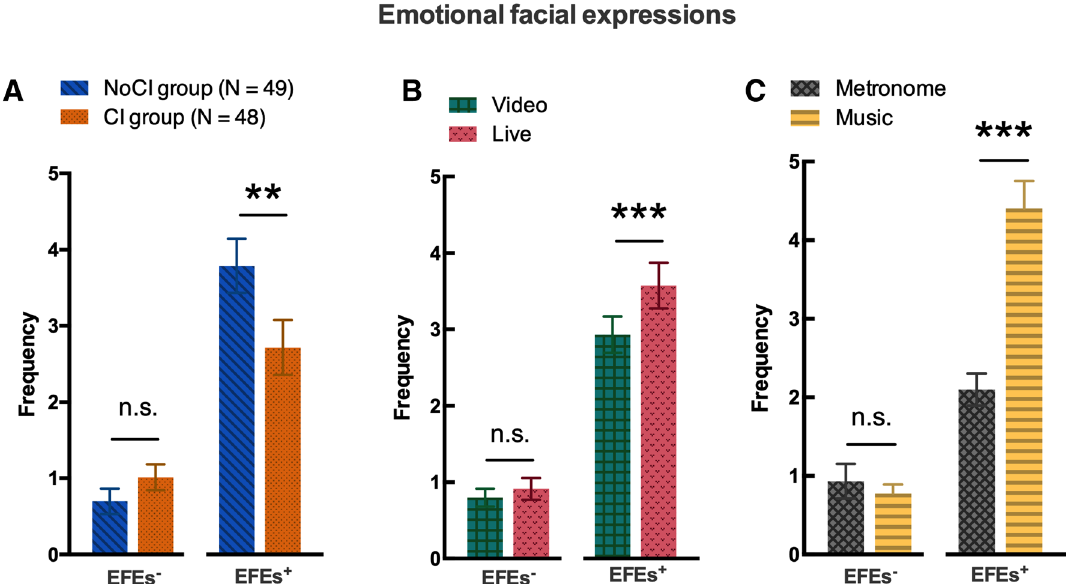
Figure 2. Emotional facial expressions. The mean ± SEM frequency of EFEs + and EFEs − , as a function of ( A ) the group (CI/NoCI), ( B ) the social context (video or live performance), and ( C ) the sound sequence (metronome or music). The production of EFEs − was not influenced by the group or any of the experimental